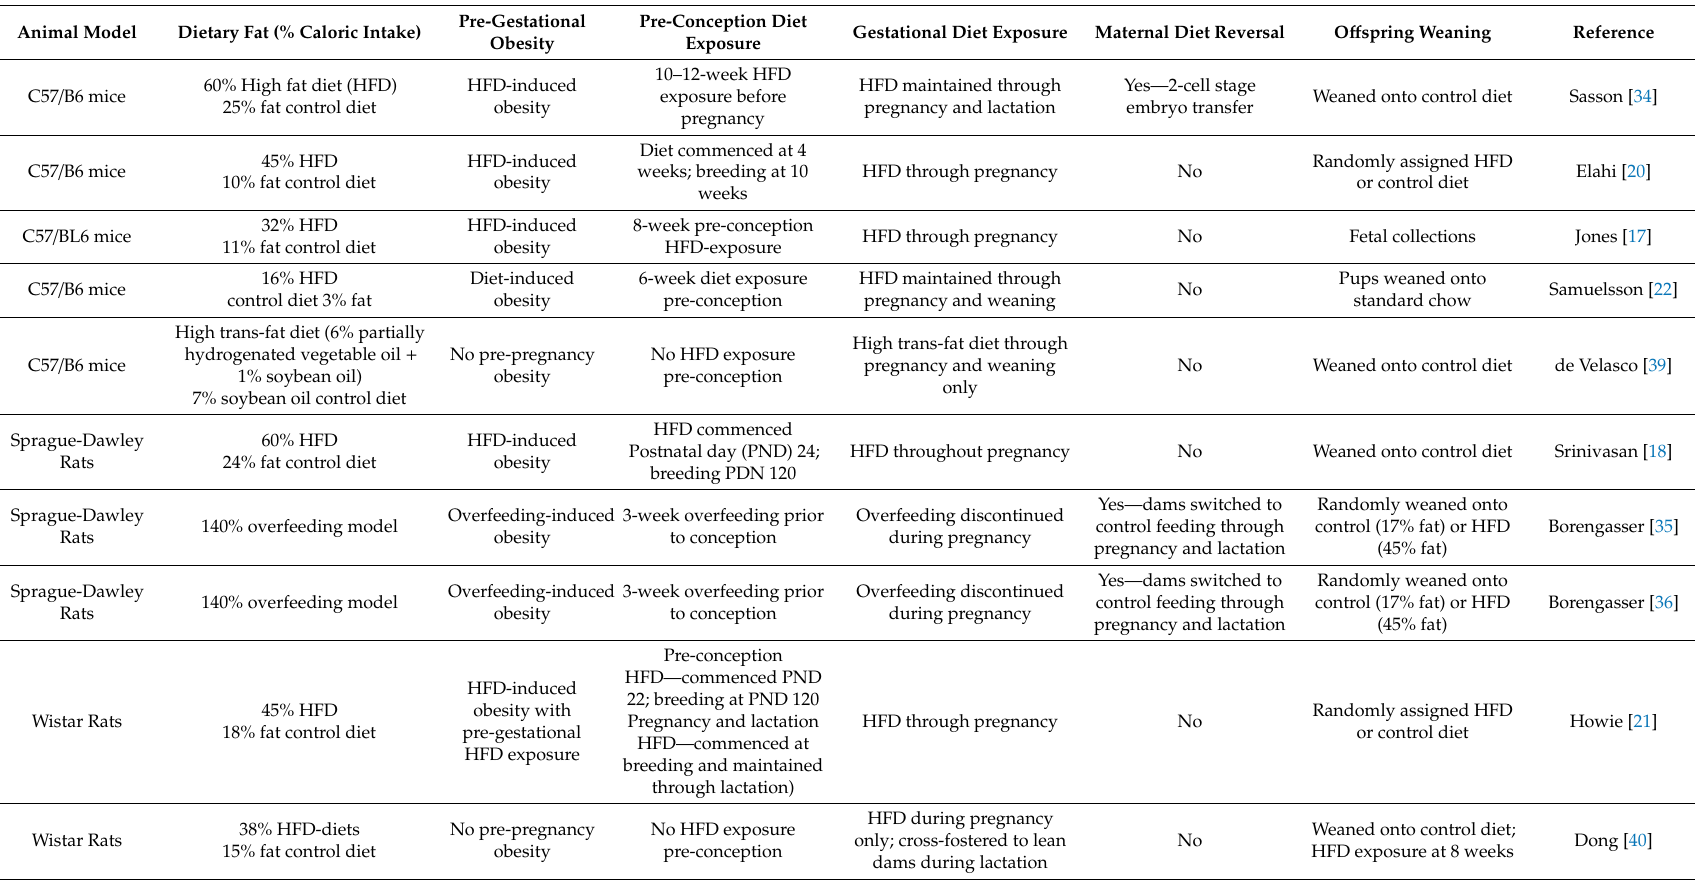
Table 1. Summary of diet fat or feeding treatments utilized in animal models of maternal diet-induced gestational obesity and gestational high-fat exposure with and without diet